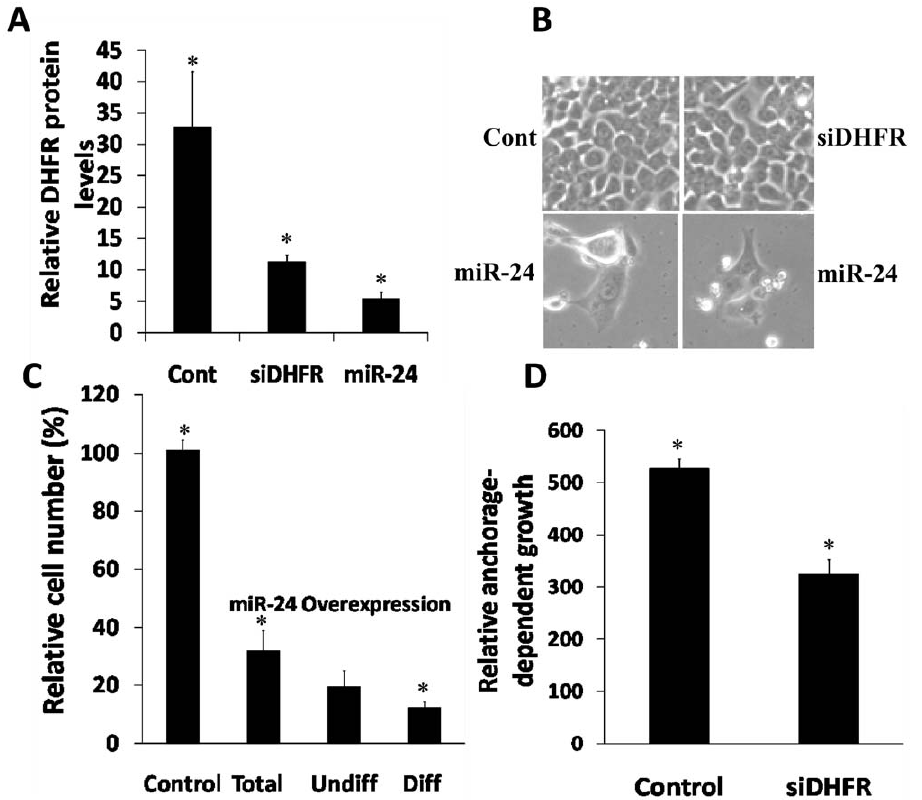
Figure 4. Overexpression of miR-24 down regulated DHFR expression, reduced anchorage-dependent growth, and induced morphological changes resembling differentiation. (A) DHFR protein levels were down regulated upon over-expression of DHFR specific siRNA (siDHFR) (by three fold) and miR-24 (by six fold). (B) miR-24 over expression conferred morphological changes that resembled differentiated in a colorectal cancer cell line (HCT-116-wt-p53). The differentiated-like morphological changes were not observed in HCT-116 cells transfected with siDHFR and oligofectamine alone (Cont). (C) Due to a lack of well established differentiation markers, the morphological changes in miR-24 transfected cells were quantitated by light microscopy. Although miR-24 transfection resulted in approximately 70% reduction in cell proliferation, approximately 12% of the total transfected cells, and 38% of total surviving cells, showed a differentiation-like phenotype. (D) Of interest, siRNA specific to DHFR that down regulated DHFR levels in the cells by threefold also reduced anchorage-dependent growth of the HCT-116 colorectal cancer cell line, suggesting that DHFR levels in the cell are associated with cell proliferation (data are shown as mean 6 SD. *, P , 0.05).